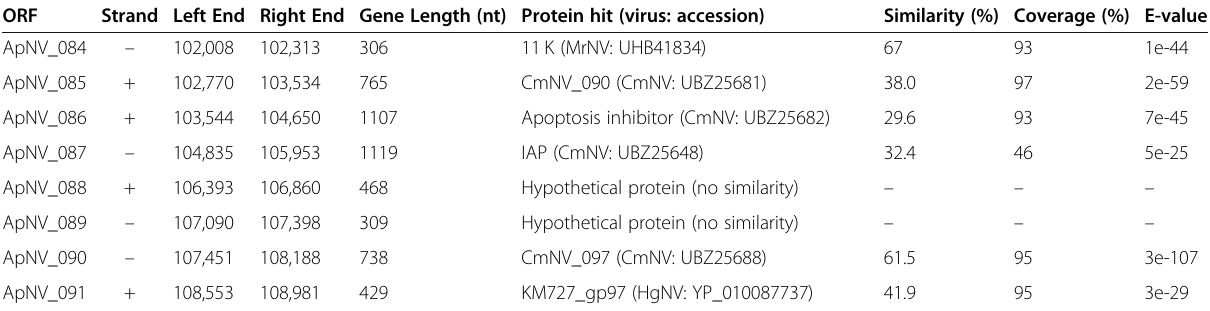
Table 2 ‘ Aratus pisonii nudivirus ’ (ApNV) protein similarity table. Similarity and function/domain are determined using BLASTp (Continued) Strand Left End Right End Gene Length (nt) Protein hit (virus: